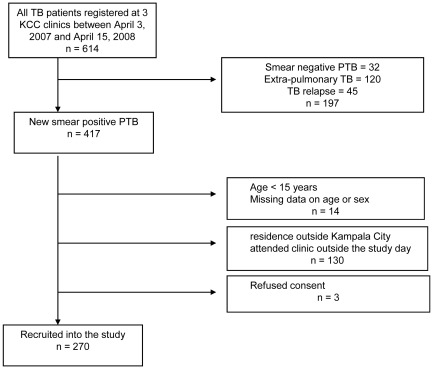
Flow chart showing the patients included in the defaulting to tuberculosis treatment study, Kampala, Uganda 2007–2008.KCC = Kampala City Council, TB = Tuberculosis, PTB = Pulmonary tuberculosis.